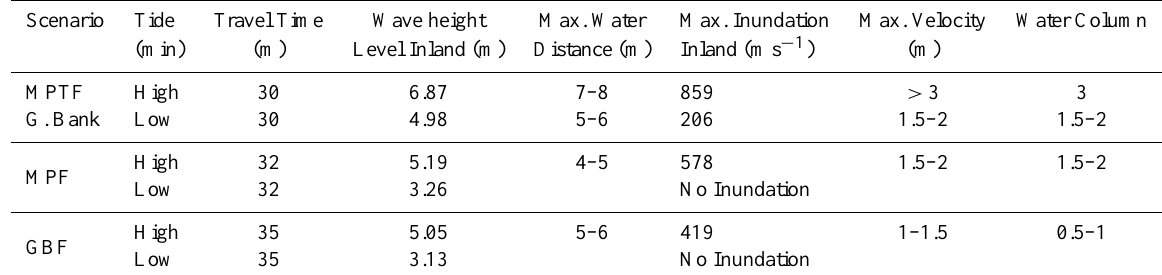
Table 3. Results of simulated events for Set´ubal.